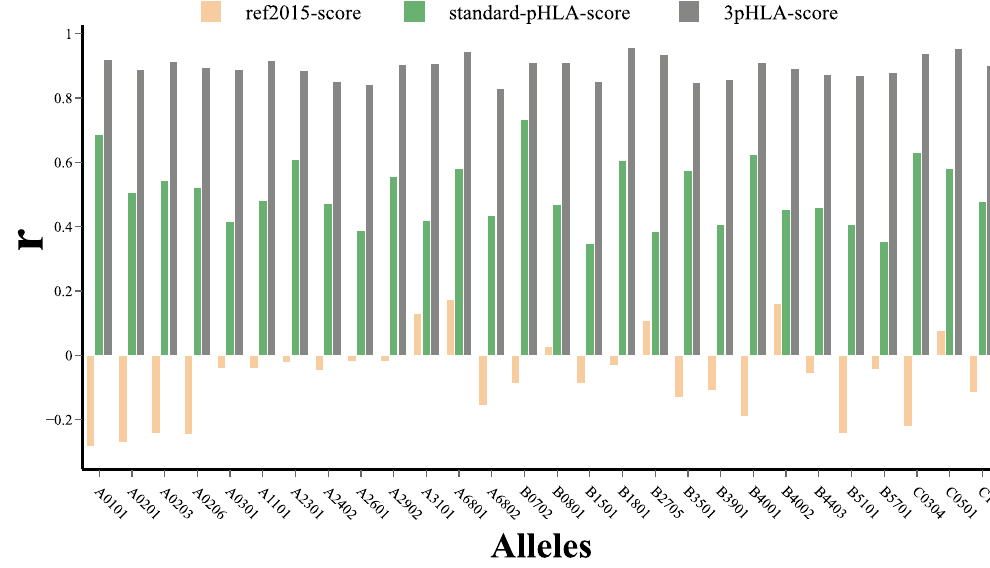
Figure 2. The predictive power of ref2015-score, standard-pHLA-score, and 3pHLA-score is evaluated and compared on the test portion of Dataset 1. Results are reported for individual alleles, listed on the x-axis. The regression power of the scores is quantified using Pearson’s r , on the y-axis.